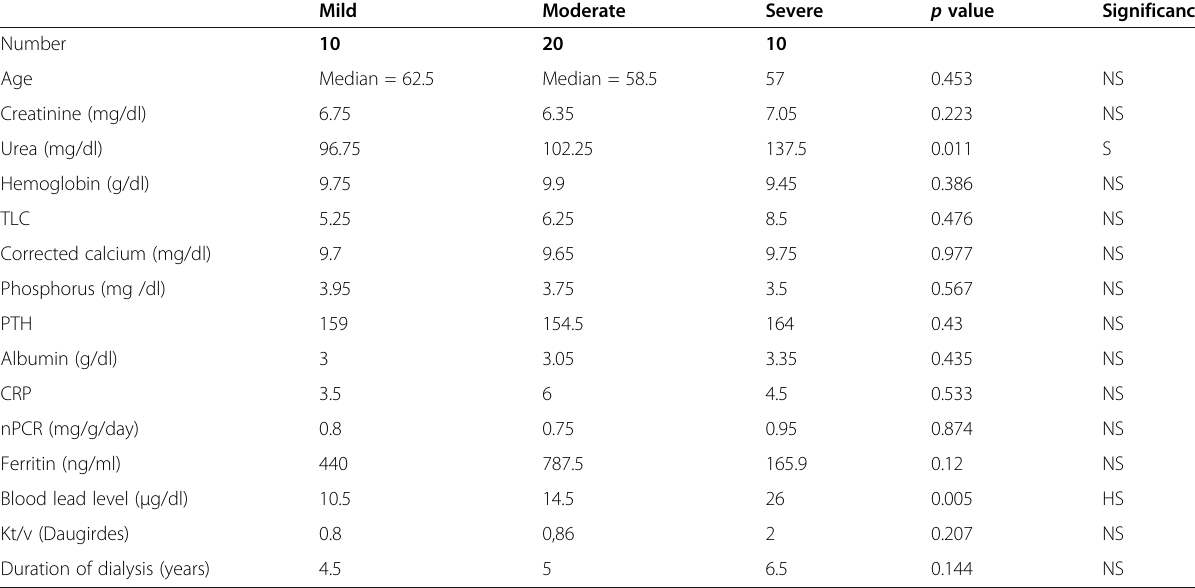
Table 3 Correlation between patients with different degrees of pruritus and serum lead level for data using Kruskal-Wallis test Mild Moderate Severe p